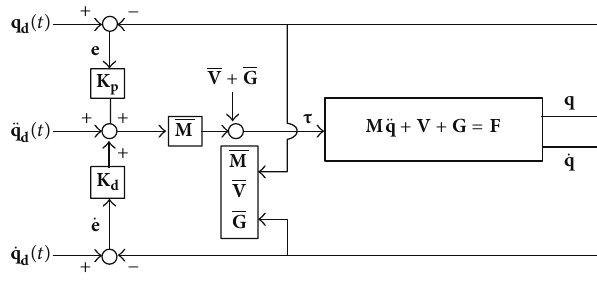
Figure 5: Model based control algorithm